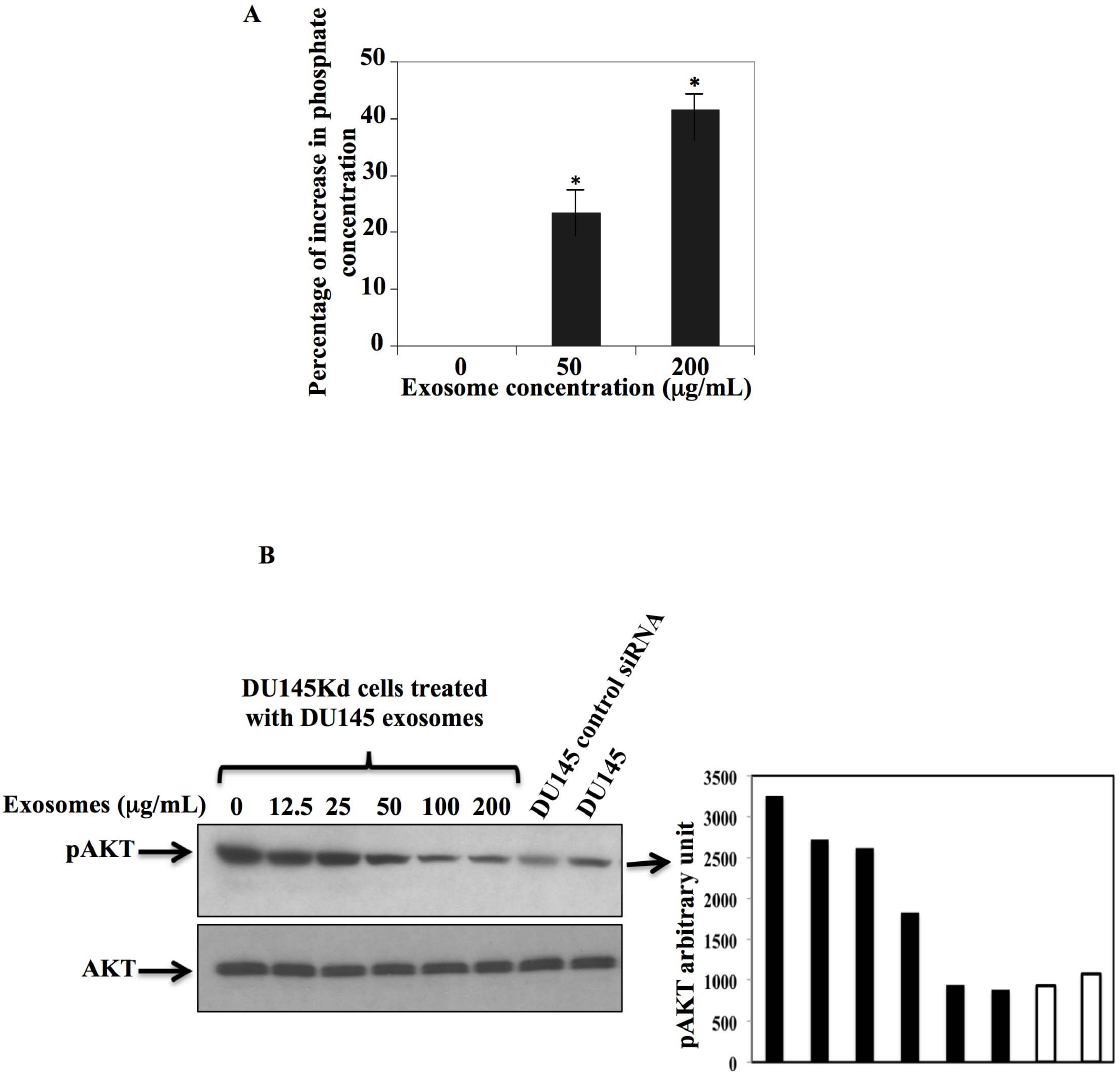
Figure 3. Exosomes transfer active PTEN to acceptor cells. A. DU145Kd cells were treated with exosomes derived from DU145 cells. PTEN was immunoprecipitated with PTEN antibodies, and PTEN phosphatase activity was assessed using the water-soluble substrate DiC8PtdIns (3, 4, 5) P3 (Echelon). The released free phosphates were measured with BIOMOL Green reagent and normalized against a reaction containing only PIP3 substrate. The results represent the average of three experiments 6 SEM, and they are significant at P , 0.01. B. PTEN-positive exosomes (from DU145) caused a decrease in AKT phosphorylation in acceptor cells (DU145Kd); AKT phosphorylation decreased to a level comparable to DU145 cells with control siRNA, and the parental counterpart DU145 cells (last two lanes to the right, respectively). C. DU145Kd cells were plated in 100-mm cell culture dishes and treated with different concentrations of DU145-derived exosomes. The cells were lysed and analyzed by immunobloting with p27 and cyclin D1 antibodies. PTEN induced the expression of p27 and reduced the expression of cyclin D1 (C). The two events led to the cells